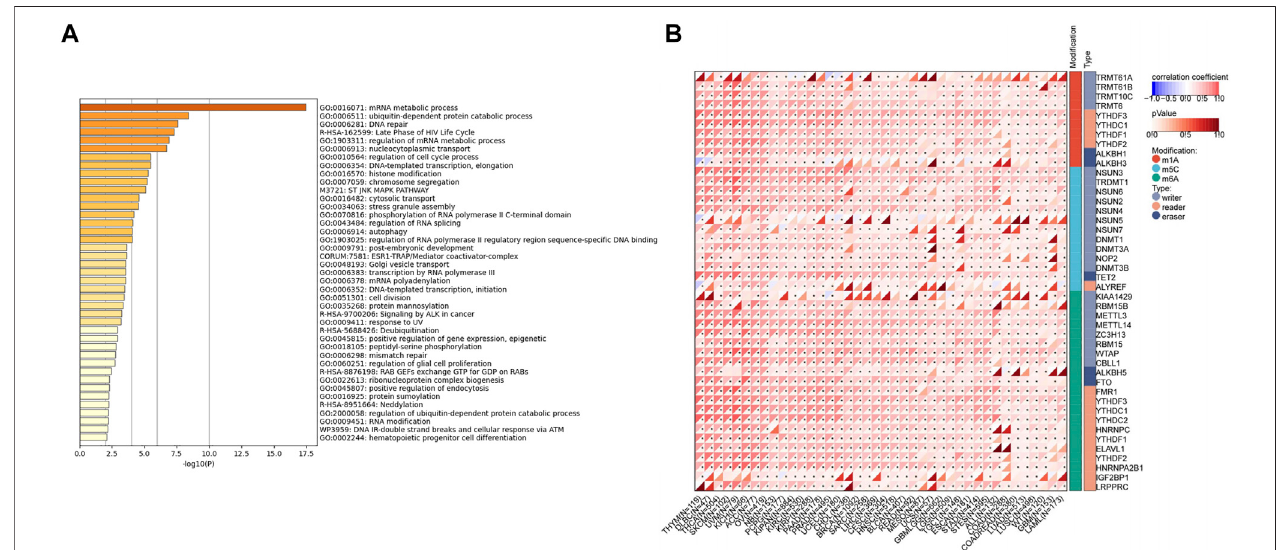
FIGURE 4 | Correlation of USP45 with mRNA methylation modi fi cations in different types of tumor. (A) The similar genes of USP45 were analyzed and obtained through the GEPIA website. Then, we performed GO analysis and KEGG pathway analysis on similar genes of USP45 via the metascape website. (B) The correlation of USP45 with Writer, Eraser, Reader of m6A RNA methylation, m5C RNA methylation, and m1A RNA methylation in different types of tumors was analyzed based on the TCGA database.